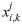
Approximation of one Markov model from the generator shown in Fig 2.Here, one part of the Generator (green box) is approximated by two Experts (yellow boxes). While both Experts have insufficient number of states, the bottom one mitigates this problem by increasing the order of its Markov chain (parameter Th in Eq (4)). The xi,kj denotes the hidden state i of Expert k in layer j. The top Expert k = 1 (which models the process with Markov order 1) shows that the original process cannot be learned well if it has an insufficient number of states (the red Expert states corresponds to the red Generator states S00 and S80 in the original process). Given the state x0,10, the Expert is unable to predict the probabilities of the next states correctly. Compared to this, the bottom Expert k = 0 models the process with Markov order 2 (Th = 1), therefore the probabilities of the next states depend on the current and previous state (indicated by arrows across 3 states in the image). In this case, despite the fact that x0,00 is ambiguous, the bottom Expert can correctly predict the next state of the original process (for simplicity, transition probabilities are illustrative and not all are depicted).